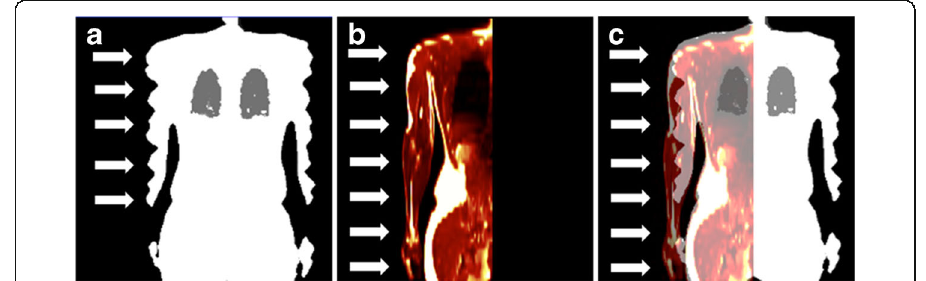
Fig. 2 Truncation artefact correction in hybrid PET/MRI imaging. The FOV in MR imaging is limited, leading to signal truncations in the MR-based attenuation map (A, arrows along the arms). These signal truncations cause an attenuation bias during attenuation correction (under-correction). The HUGE technique increases the FOV in MR imaging eliminating these artefacts (B, arrows ). The fusion of truncated attenuation map (A) and the HUGE images (B) shows this effect